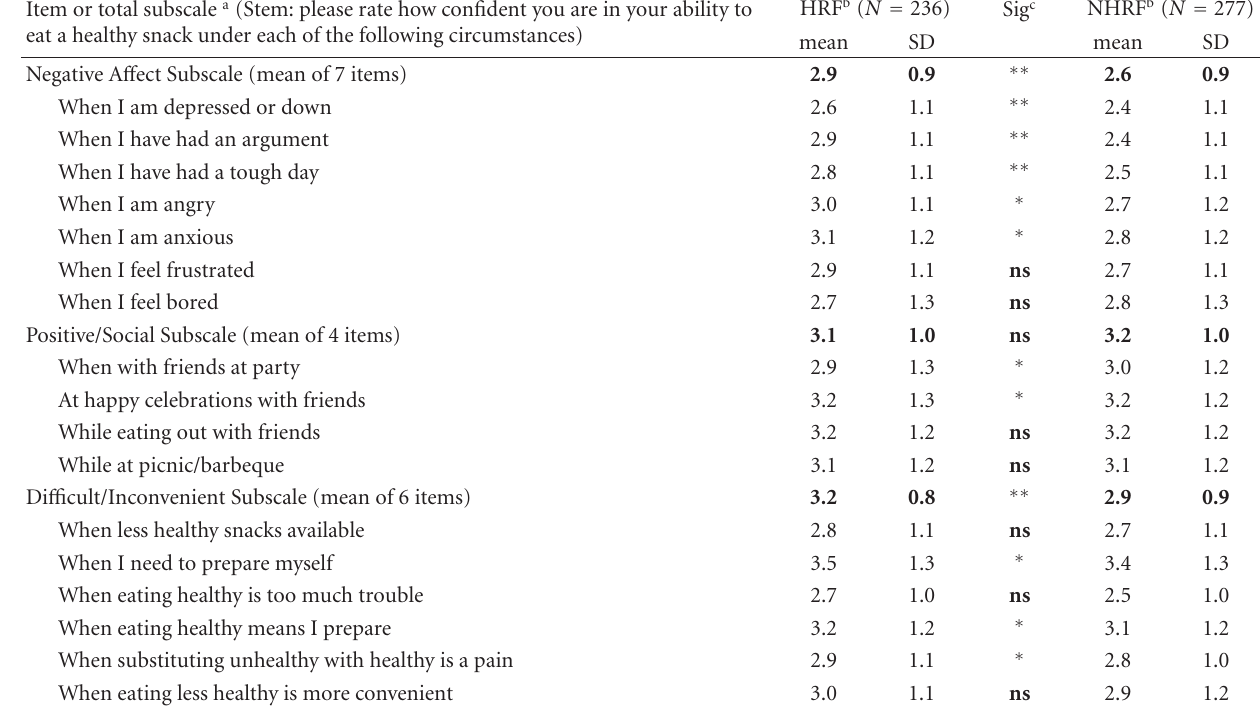
Table 2: Mean Ratings on situational self-e ffi cacy subscales for eating healthy snacksfor 513 college